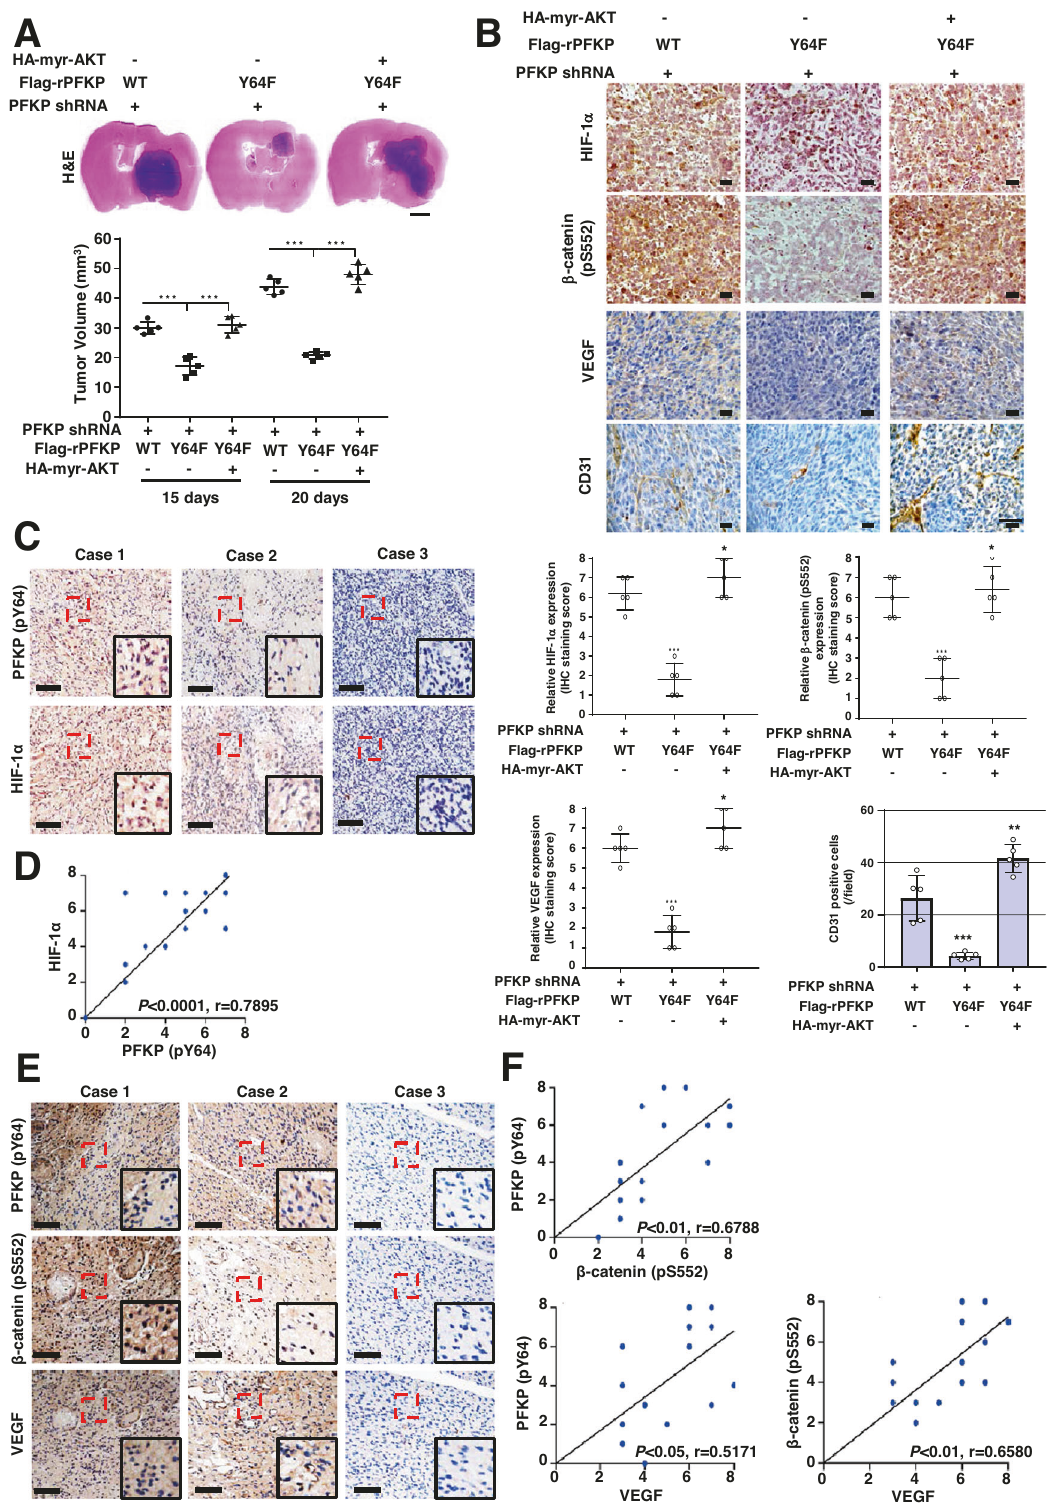
Fig. 4 PFKP Y64 phosphorylation induces HIF-1 α expression, β -catenin S552 phosphorylation, and VEGF expression and promotes blood vessel formation in vivo. A Representative H&E staining images of intracranial xenografts bearing PFKP-depleted LN229/EGFRvIII cells with or without reconstituted expression of WT Flag-rPFKP or Flag-rPFKP Y64F mutant with or without myr-AKT1 ( A ; upper panel) and quanti fi cation of tumor volumes ( A ; bottom panel). Scale bar, 2 mm. B IHC analyses of tumor tissues with the indicated antibodies (upper panel). Quanti fi cation of indicated IHC staining (bottom panel). Scale bar, 100 μ m. C , E IHC staining of human GBM specimens was performed with indicated antibodies ( n = 25). Representative images from the staining of three different specimens are shown. Scale bar, 100 μ m. D , F The IHC stains were scored, and correlation analyses were performed. The Pearson correlation test was used. Note that the scores of some samples overlapped. *** P < 0.001, based on one-way ANOVA with Tukey ’ s post hoc